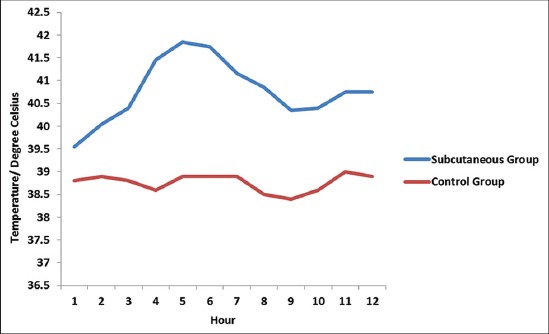
Mean rectal temperatures for the subcutaneous group after 12 h of inoculation with Pasteurella multocida Type B:2.